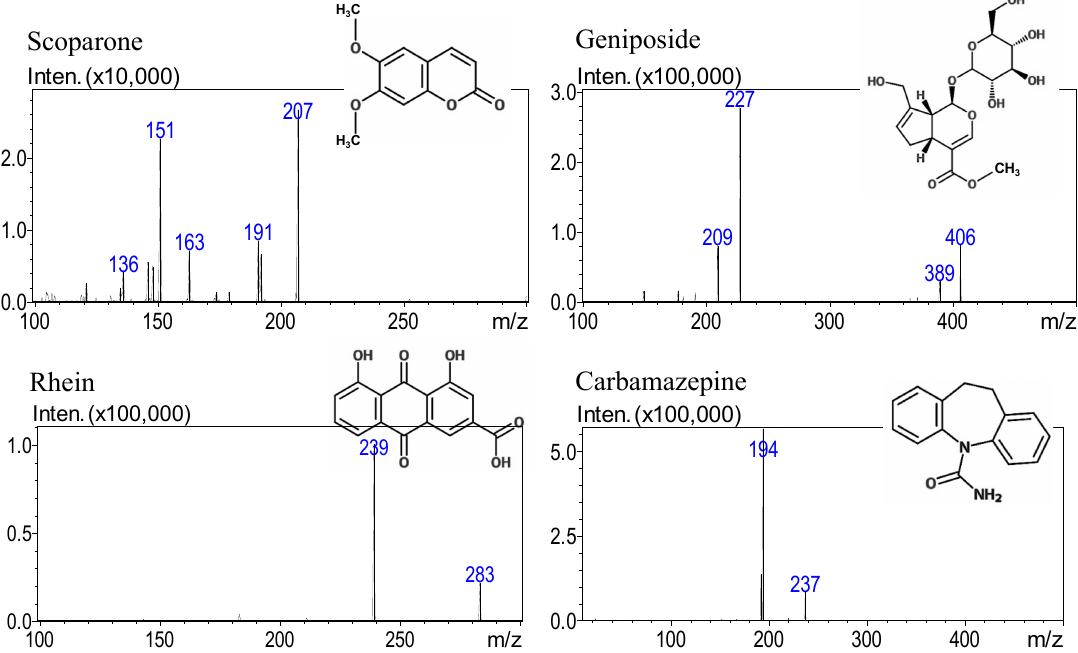
Figure 1. ESI-MS/MS spectra of bioactive constituents of the Yin-Chen-Hao-Tang formula and the internal standard. Scoparone (M + H) + , geniposide (M + NH 4 ) + and carbamazepine (M + H) + spectra are obtained using ESI + while rhein (M − H) − was in ESI − .